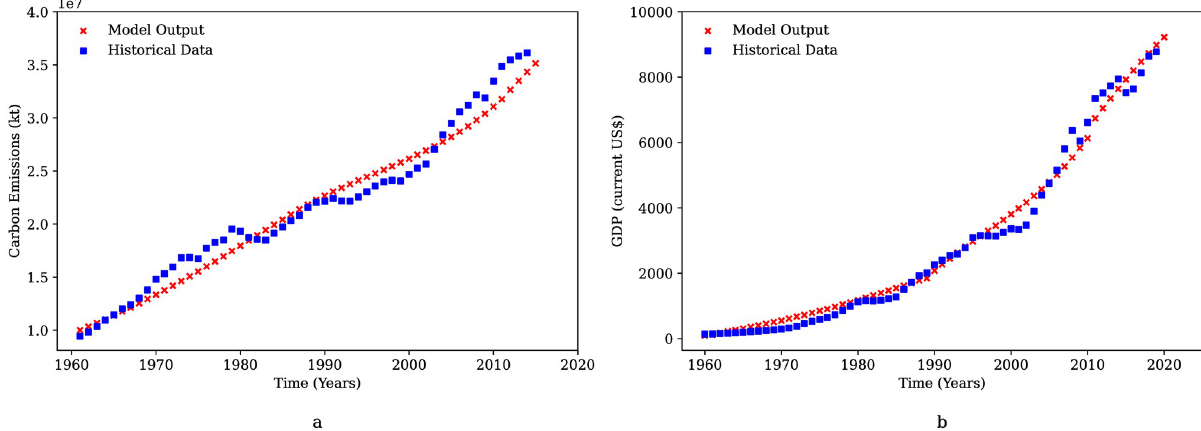
Fig 4. Comparison of model predictions denoted as “Model Output” against available historical data: a: Carbon emissions (CO 2 ) b: GDP (USD).